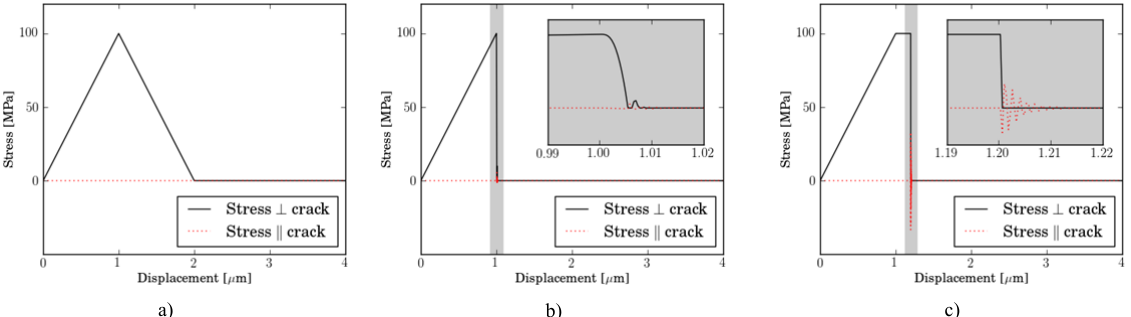
Fig. 6 Stress evolution for unit element model using Hillerborg failure model with a) G Ic = 100 J/m 2 , b) 50 J/m 2 and c) 10 J/m 2 .